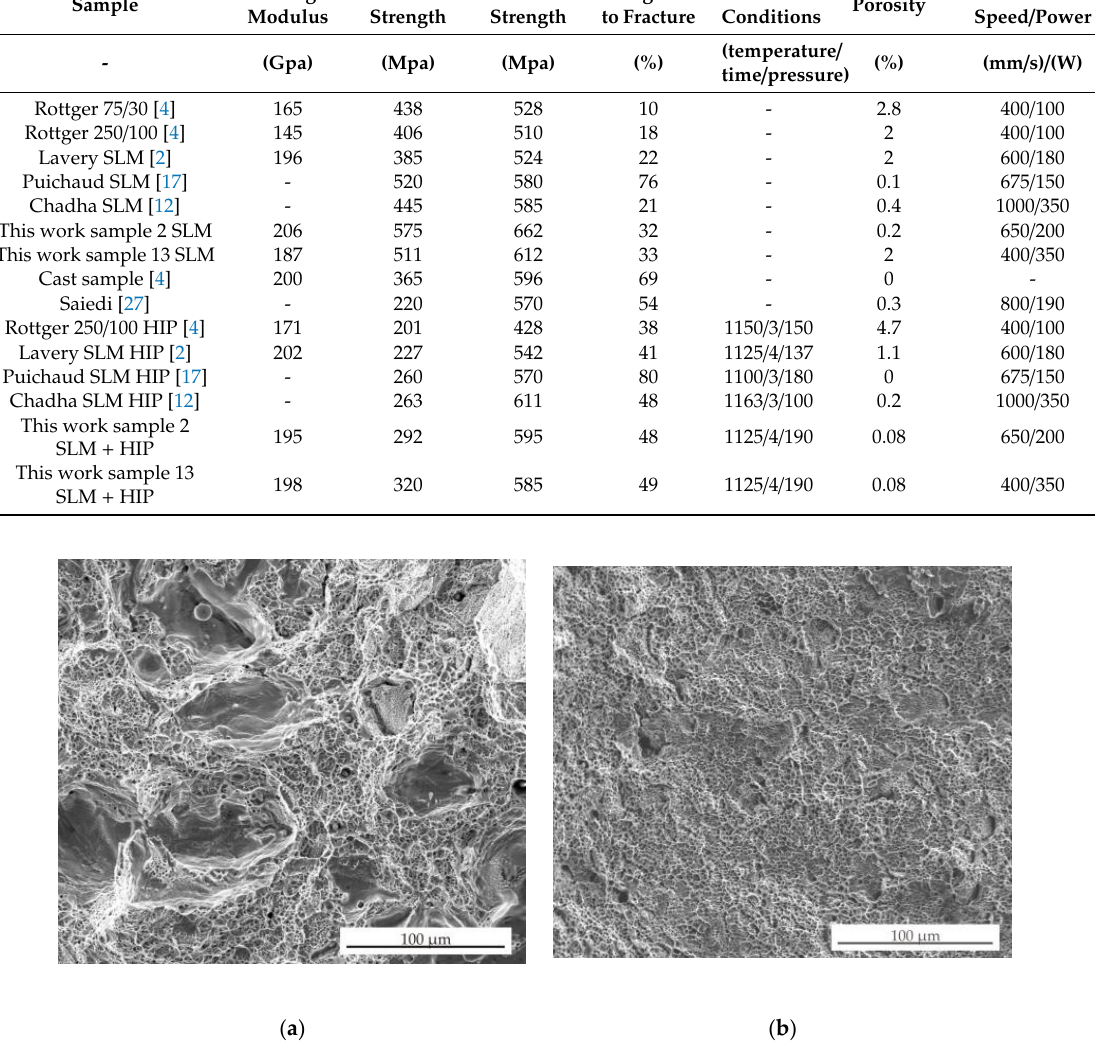
Figure 27. Fracture surfaces of sample ( a ) 13 after SLM and ( b ) 13 after SLM + HIP_2